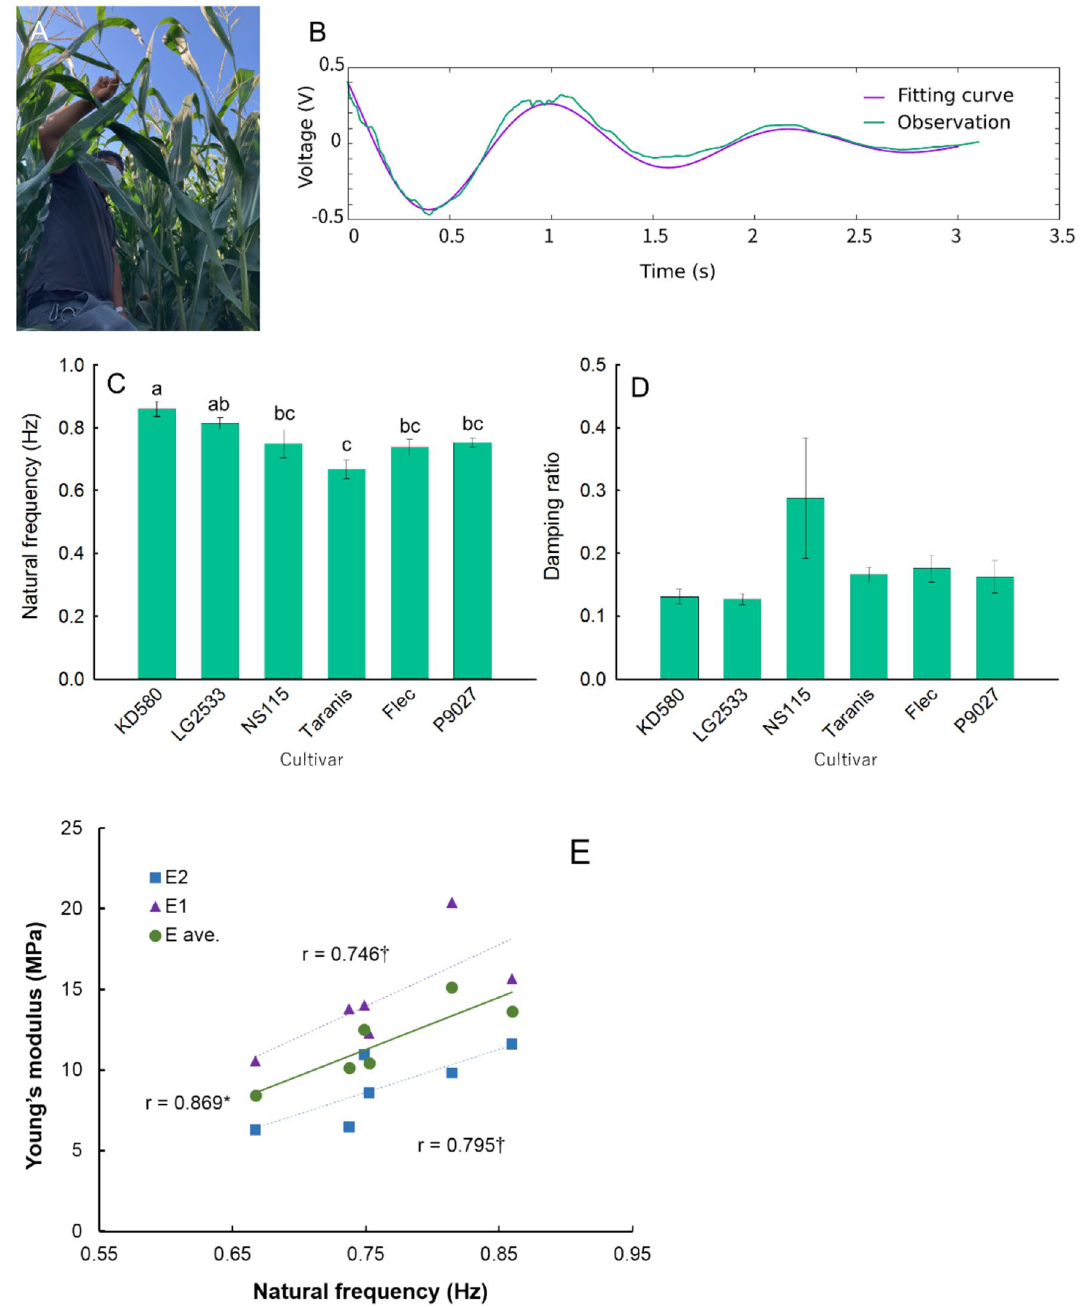
Figure 3. Experimentally determined natural frequency and damping ratio. ( A ) Bending vibration test for measuring the step response associated with the bending mode. ( B ) The vibration data were bandpass filtered at 0.1–10.0 Hz to remove noise. Subsequently, the response was fit by the analytical solution of the damped free vibration problem. ( C , D ) The natural frequency and the damping ratio obtained from the fitting of the observation. ( E ) The relationship between natural frequency and Young’s modulus. Values in C and D are means ± s.e. (standard error; n = 4). Tukey’s HSD test was used to examine the statistical significances at p < 0.05 and different alphabets indicate significant differences. † and * indicate statistical significance in correlation coefficient at p < 0.1 and p < 0.05,